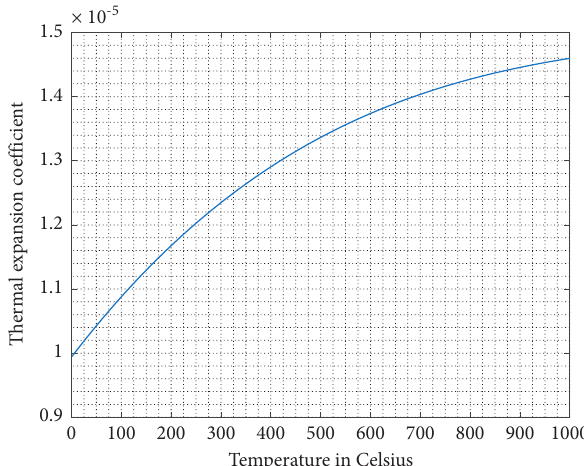
Figure 5: Thermal expansion coefficient of base material v/s